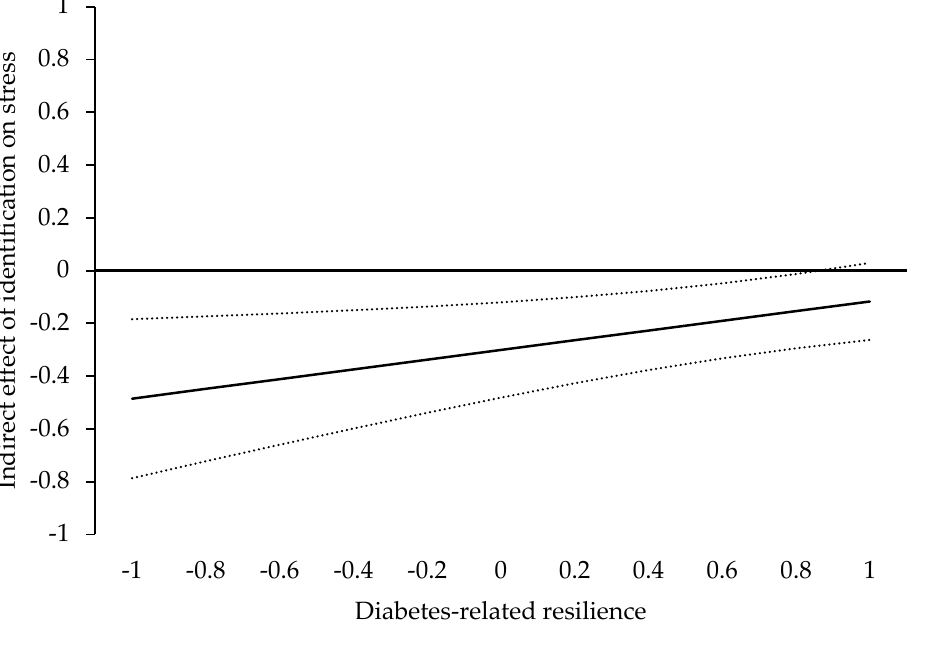
Figure 3. Visual presentation of the Johnson–Neyman Output for the indirect effect of identification with the medical practitioner on diabetes-related stress. The y -axis depicts the indirect effect; the x -axis depicts the values for diabetes-specific resilience. The solid line represents the strength of indirect effect; the dotted lines represent the lower and upper levels of the 95% confidence interval.